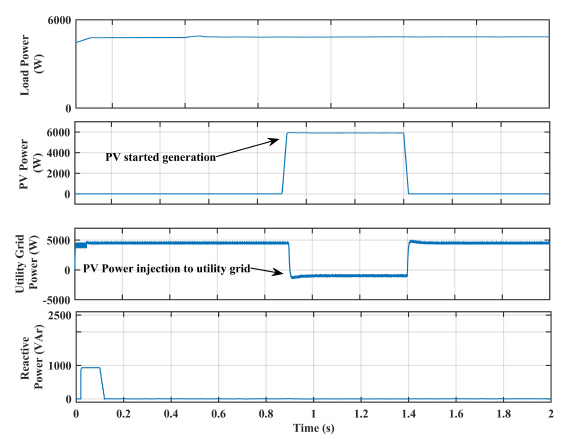
Fig. 4. Load power sharing by grid and PV.